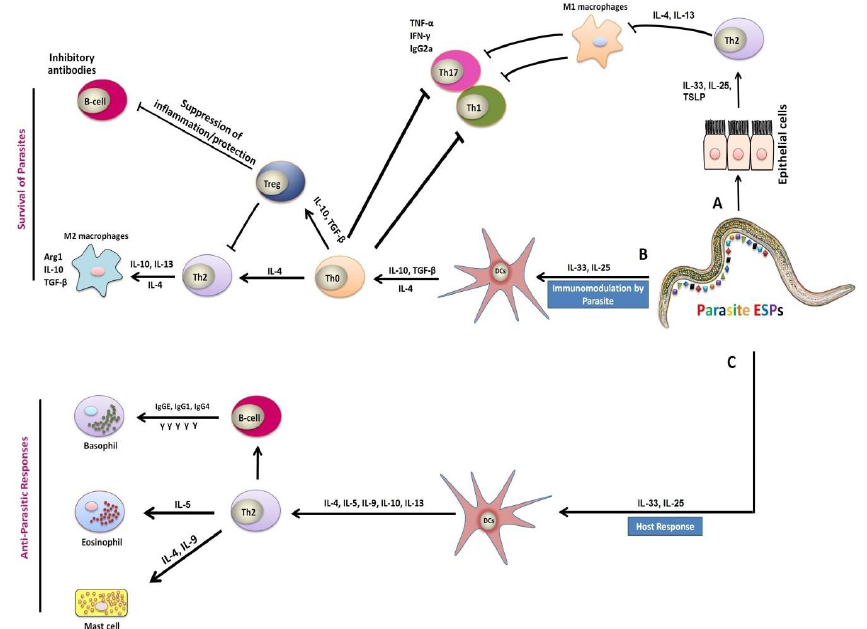
Figure 2. Mechanism of immune responses during host–parasite interactions. ( A ) Parasitic infection cause injuries to epithelial cells, which in turn stimulated and activated various aspects of the type 2 immune response with the generation of IL-25, IL-33 cytokines, and the Thymic Stromal Lymphopoietin (TSLP) cells. Macrophages exposure to the anti-inflammatory cytokines interleukin (IL)-4 or IL-13 lead to suppression of the classical activation of macrophages (M1) and stimulated expansion of the M2 phenotype [42]. ( B ) The excretory / secretory products (ESPs) released by parasite, induced immune responses linked with production of IL-25 and IL-33 cytokines, which are capable of inhibiting the activation and maturation of dendritic cells (DCs), and inducing the expansion of functional regulatory T cells (Tregs) [41]. Di ff erentiation of alternatively activated macrophages (AAMs) induced by IL-4 and IL-13 can inhibit the proliferation of Th1, Th17, and Th2 cells. Thus, these cells have strong anti-inflammatory properties, manifested by the secretion of immunoregulatory cytokines IL-10 and TGF- β , aswellasotherrelatedgenes[40]. ( C )Theparasite-inducedTh2immuneresponsestogetherwith release of IL-25 and IL-33 cytokines are also responsible for the activation of DCs after the recognition of antigens by receptors on the DCs of the host [43]. These responses included IL-4, IL-5, IL-9, IL-10, and IL-13 secretions in addition to the production of immunoglobulin G (IgG) and immunoglobulin E (IgE) by B cells, and the activation of e ff ector cells such as basophils, eosinophils, and mast cells, which caused secretions of inflammatory mediators responsible for parasite expulsion